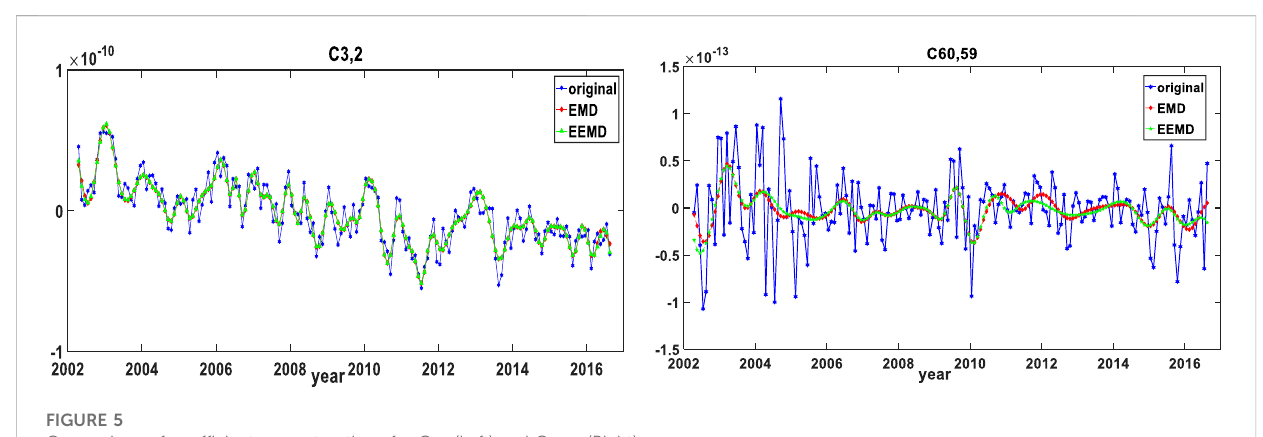
FIGURE 5 Comparison of coef fi cient reconstructions for C 3,2 (Left) and C 60,59